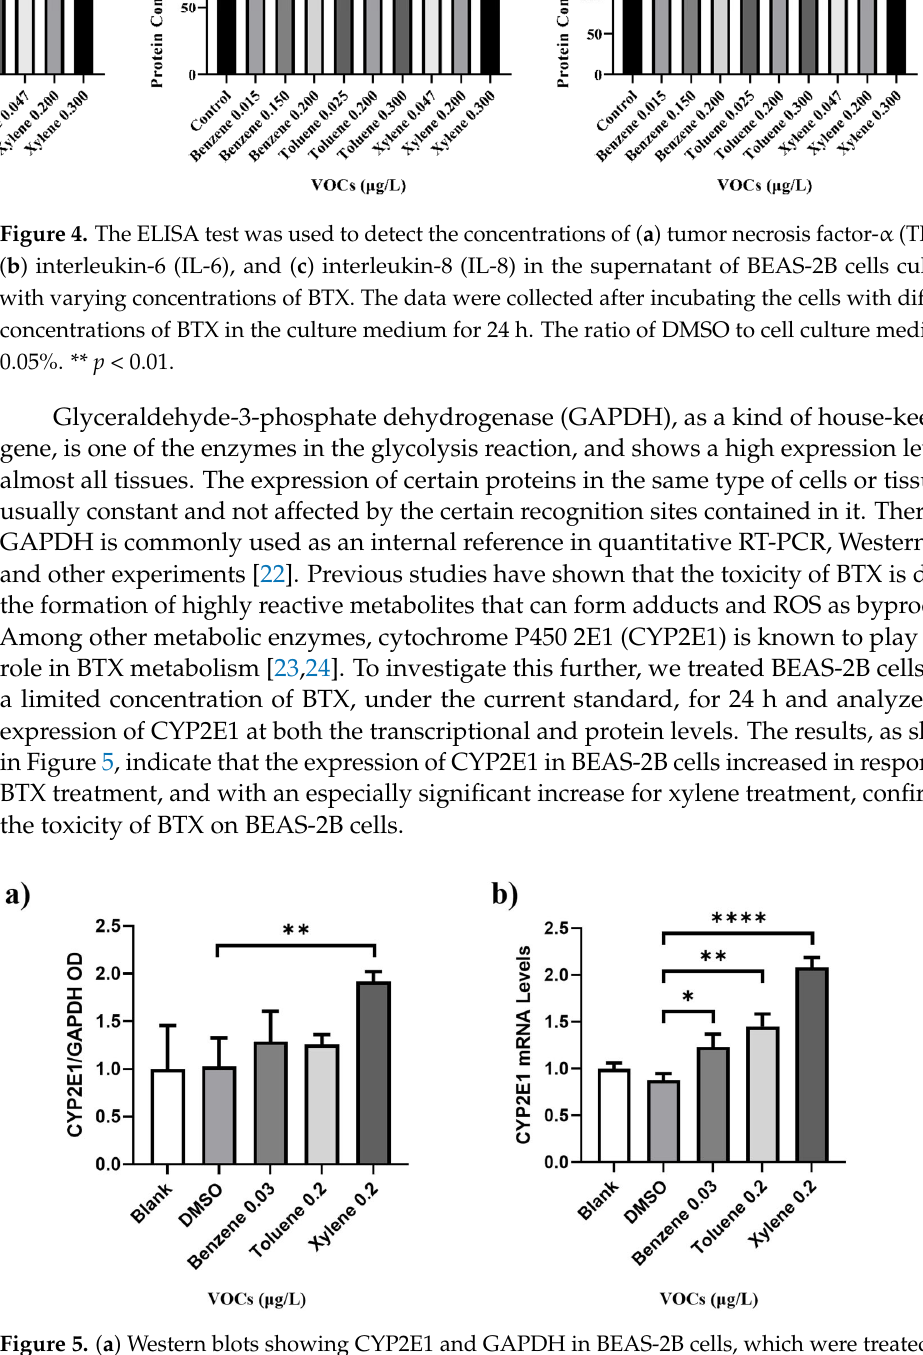
Figure 5. ( a ) Western blots showing CYP2E1 and GAPDH in BEAS ‐ 2B cells, which were treated with indicated doses of DMSO, benzene (0.03 μ g/mL), toluene (0.2 μ g/mL), and xylene (0.2 μ g/mL), for 24 h. ( b ) qRT ‐ PCR analysis of CYP2E1 in BEAS ‐ 2B cells after doses of DMSO, benzene (0.03 μ g/mL), toluene (0.2 μ g/mL), and xylene (0.2 μ g/mL) for 24 h. Data shown are means ± SD of two independ ‐ ent experiments. * p < 0.05, ** p < 0.01 and **** p < 0.0001.